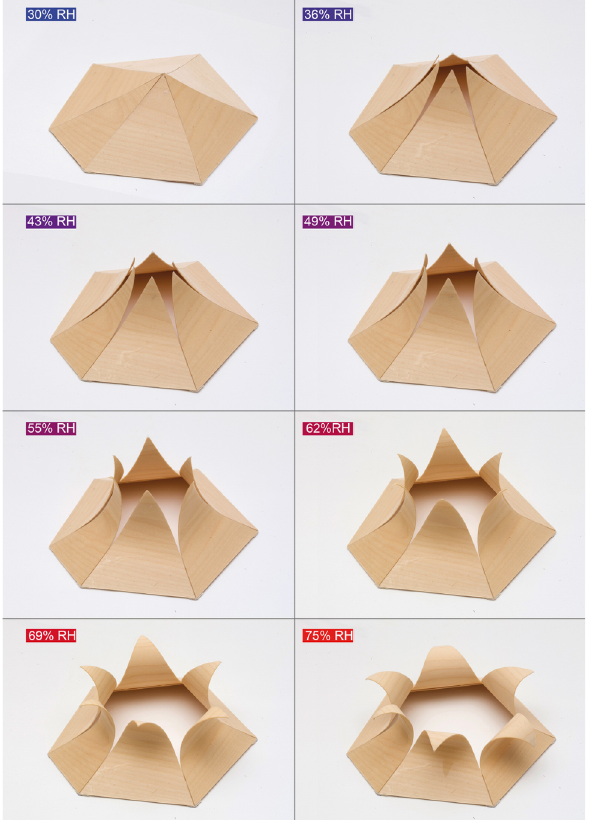
Figure 7 | HygroSkin-Meteorosensitive Pavilion / Achim Menges Architect + Oliver David Krieg + Steffen Reichert. Process- Responsive Component. Courtesy of ICD University of